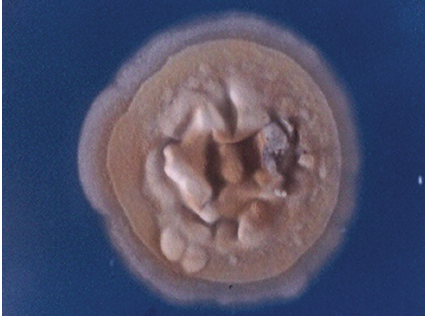
Figure 15: Pycnidial forms of genus Peyronellaea that identified Phoma, obtained in the aqueous and vitreous samples of the patient from Figure 14 × 400.